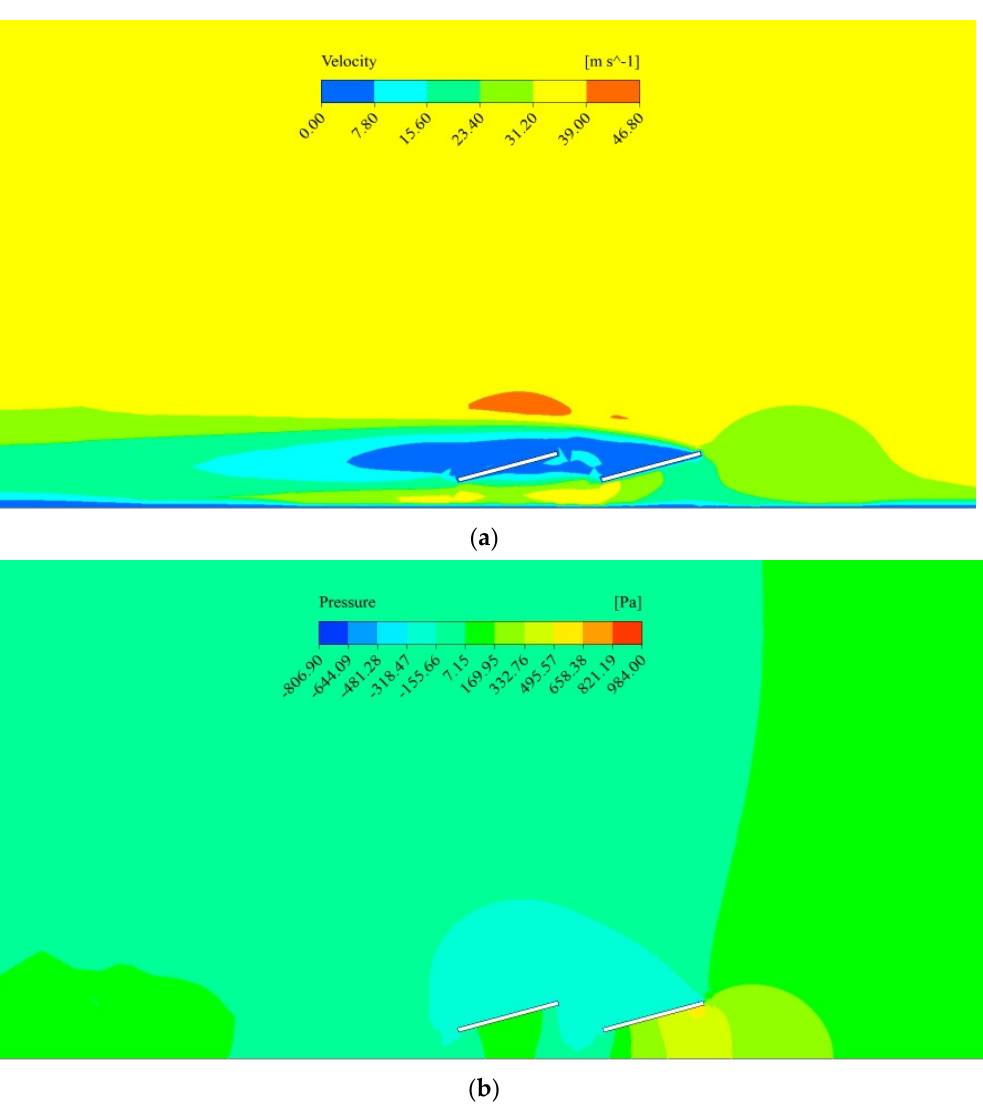
Figure 12. Case III—CFD simulation results for optimum configuration ( a ) velocity contour; ( b ) pressure contour.